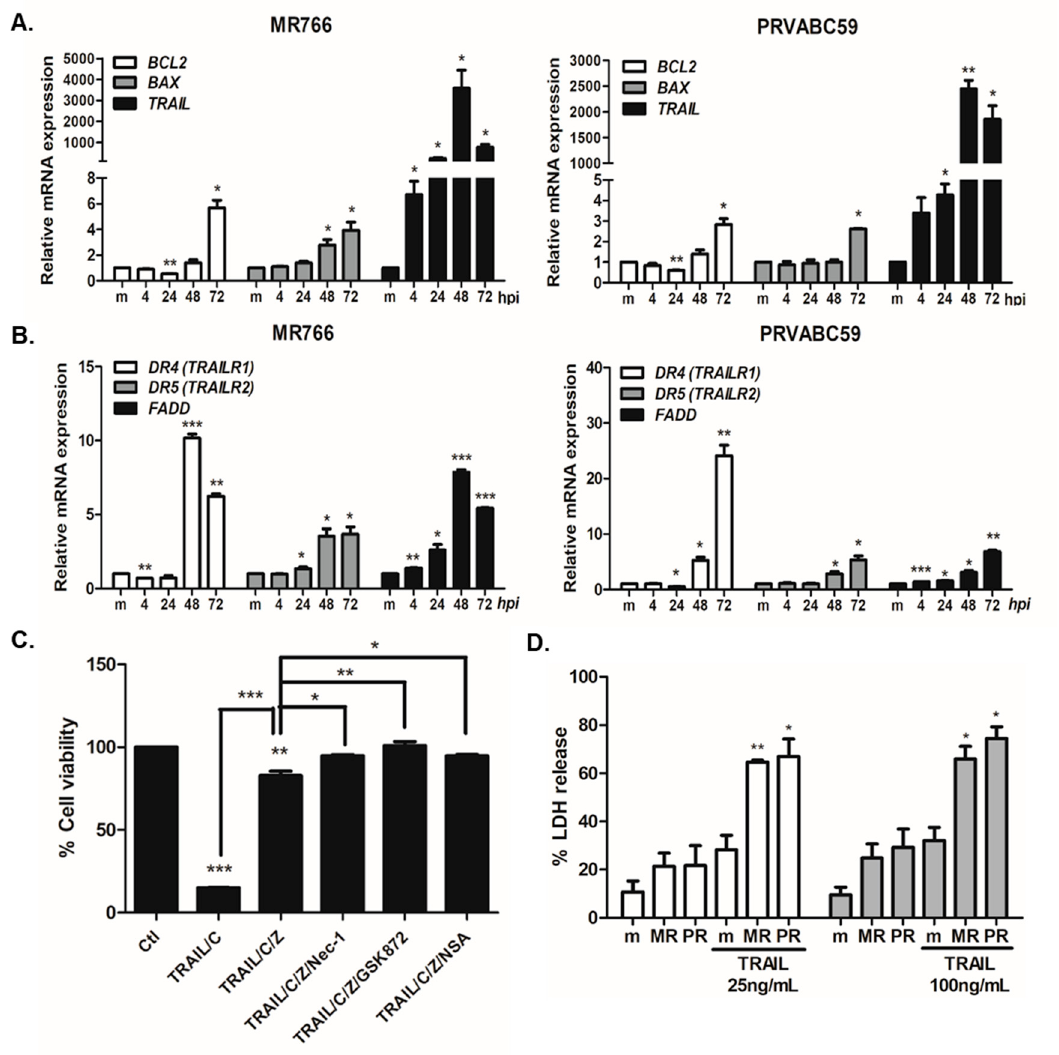
Figure 4. ZIKV infection results in increased expression of genes involved in TRAIL signaling, and TRAIL-mediated apoptosis augments ZIKV-induced cell death. ( A , B ) hNPCs were infected with ZIKV (MOI of 3) and RNA was collected at 4, 24, 48, and 72 hpi. mRNA levels of BCL2, BAX, TRAIL, TRAILR1, TRAILR2 , and FADD were measured over time using qRT-PCR. The expression of genes was normalized to β -actin and the levels of expression for the control mock-infected group were arbitrarily set to 1. * p < 0.05; ** p < 0.01; *** p < 0.001, compared with mock-infected cells. ( C ) hNPCs were treated with TRAIL and cycloheximide (TRAIL/C), TRAIL, cycloheximide, and z-VAD-fmk (TRAIL/C/Z), or TRAIL, cycloheximide, z-VAD-fmk, and Nec-1 (TRAIL/C/Z/N), TRAIL, cycloheximide, zVAD, and GSK872 (TRAIL/C/Z/N), TRAIL, cycloheximide, z-VAD-fmk, and NSA (TRAIL/C/Z/NSA). % cell survival was determined by CellTiter-Glo assay. ( D ) % LDH release was measured in the supernatants of mock- or ZIKV- infected cells followed by recombinant TRAIL treatment (25 or 100 ng/mL). * p < 0.05; ** p < 0.01; *** p < 0.001, compared with ZIKV-infected DMSO-treated cells.